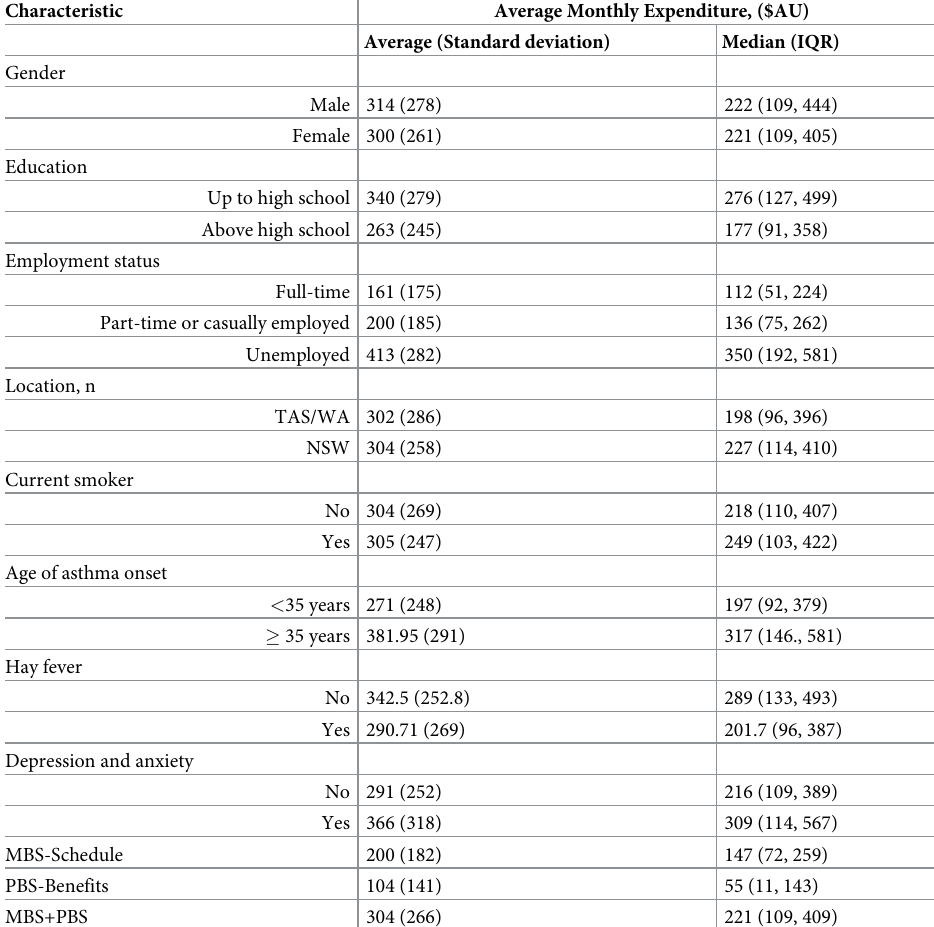
Table 4. Monthly Average Total Expenditure summary by characteristics for the study